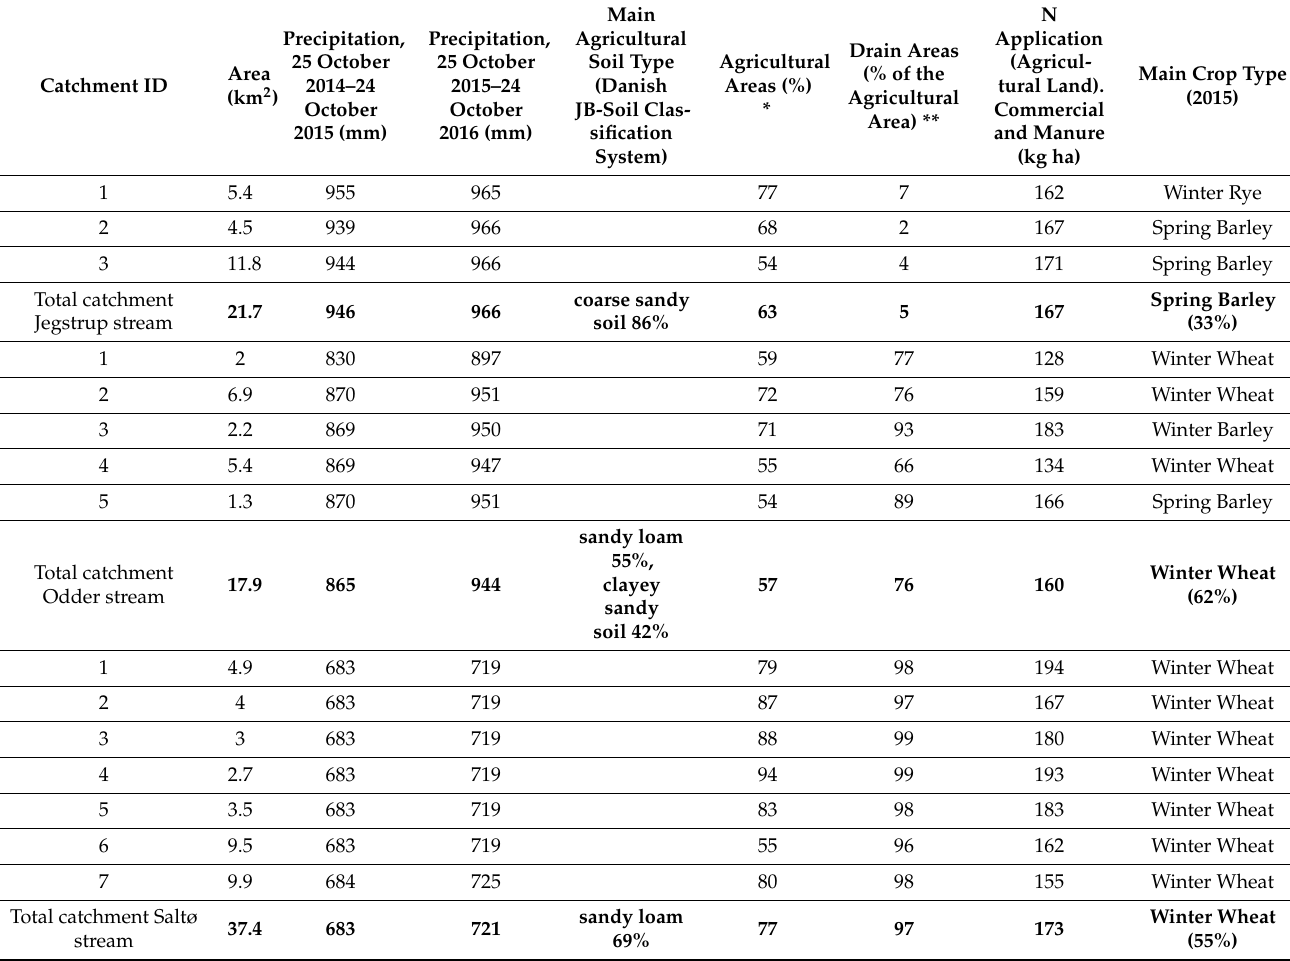
Table 1. Overview of the sub-catchments in the three study areas of Jegstrup, Odder, and